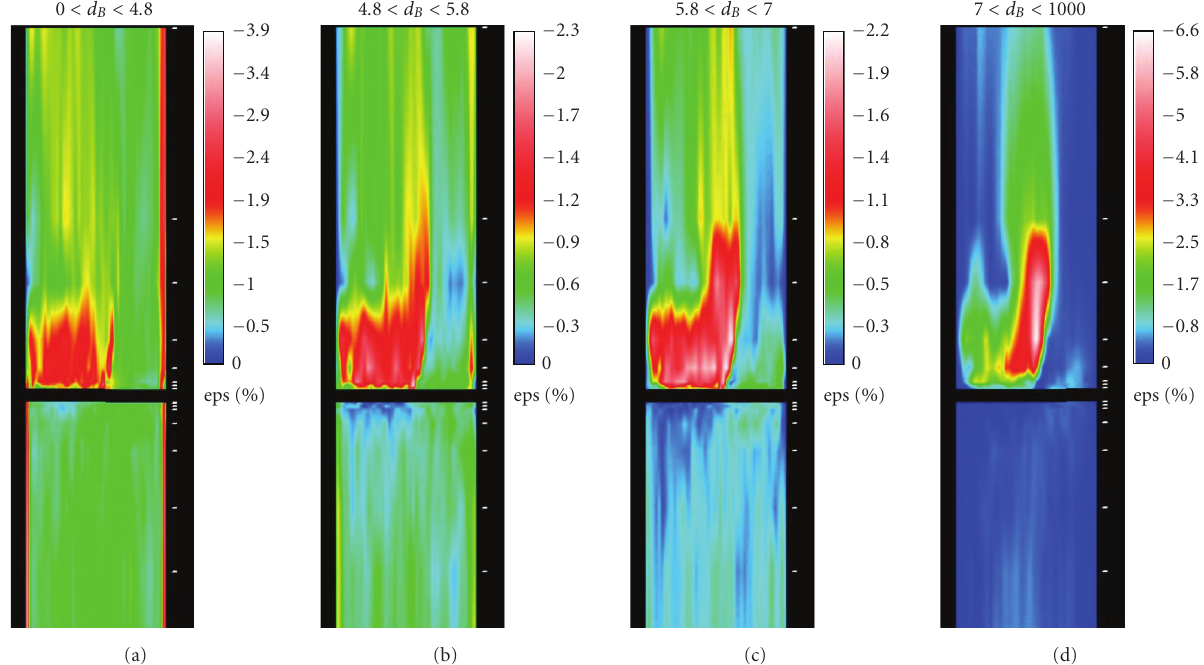
Figure 8: TOPFLOW experimental volumetric fractions of air bubbles according to di ff erent size classes, extracted from [24].